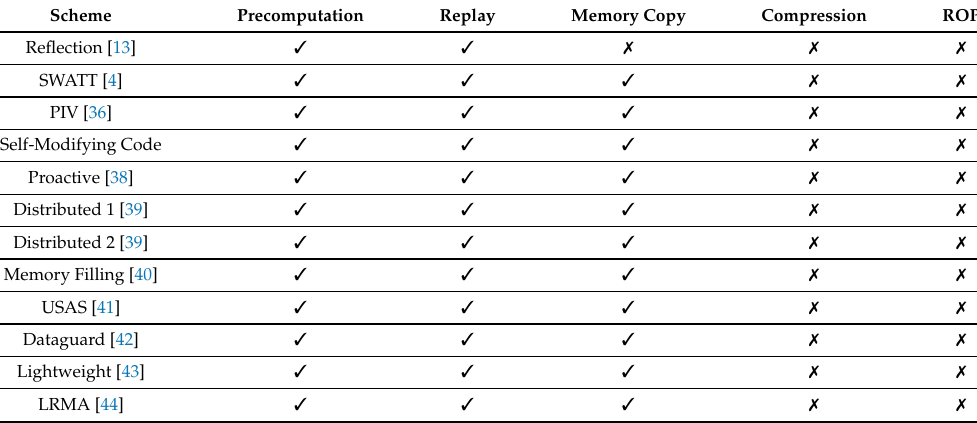
Table 5. Detection capabilities w.r.t. Attestation Adversaries.